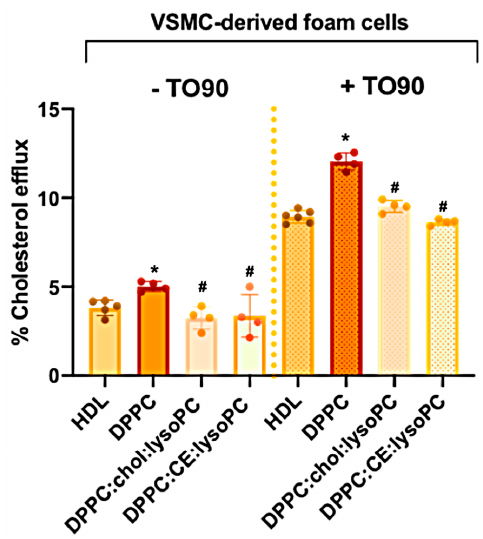
Figure 5. Effect of HDL, DPPC, DPPC:Chol:lysoPC and DPPC:CE:lysoPC rHDLs on cholesterol efflux in vascular smooth muscle cells (VSMC) derived foam cells stimulated or not with TO90. rHDLs were added to the stimulated and non-stimulated cells in MEM-Hepes 25 mM (pH 7.4) containing 2 µg/mL ACAT inhibitor and incubated during 6 h to promote cholesterol efflux. Cholesterol efflux was calculated as described in Methods. Data represent the means ± S.D. of at least three independent measurements. Levels of significance were determined by a two-tailed Student’s t -test. * p < 0.01 compared to HDL and # p < 0.01 compared to DPPC.